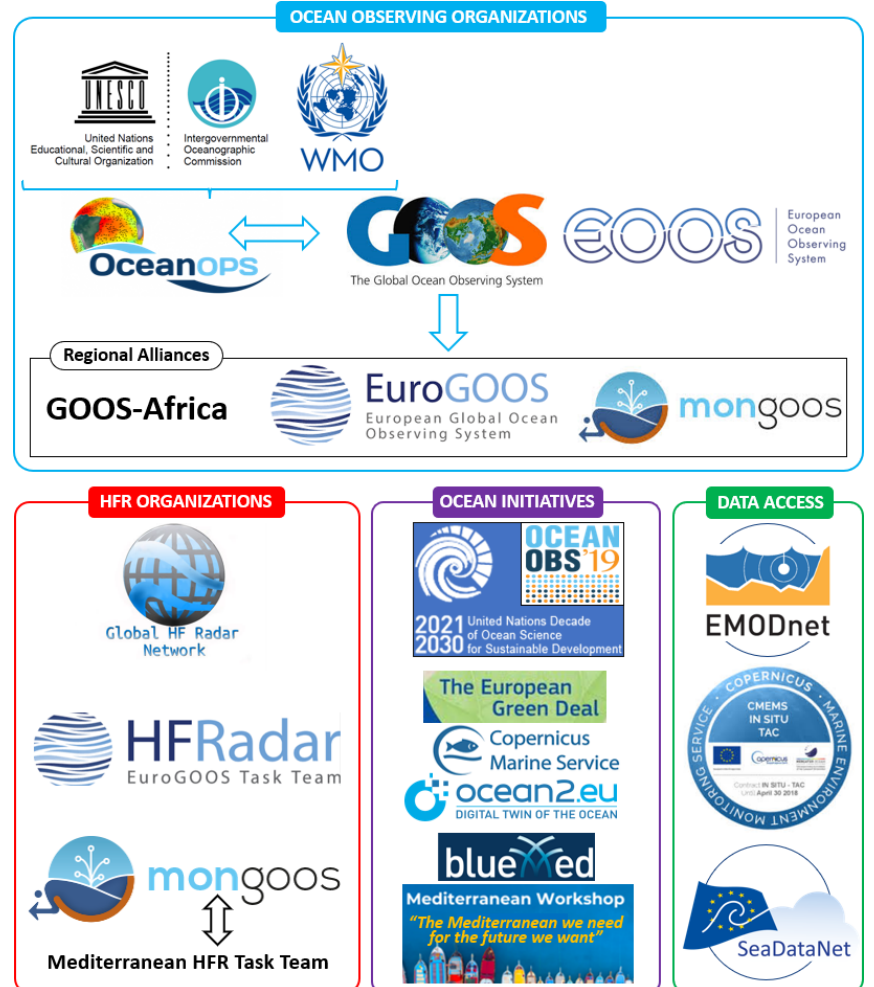
Figure 2. Conceptual framework for ocean observing systems, alliances, and initiatives ranging from global to regional scales. OceanOPS, which depends on both the UNESCO Intergovernmental Oceanographic Commission and the World Meteorological Organization, repre- sents the operational center of GOOS where meteo-oceanographic observing systems are centralized. The double-sided arrow between MONGOOS and the Mediterranean HFR task team intends to highlight the two-way interaction between the two entities: the former sets specific tasks and the general strategy, while the latter provides data and support to update the predefined